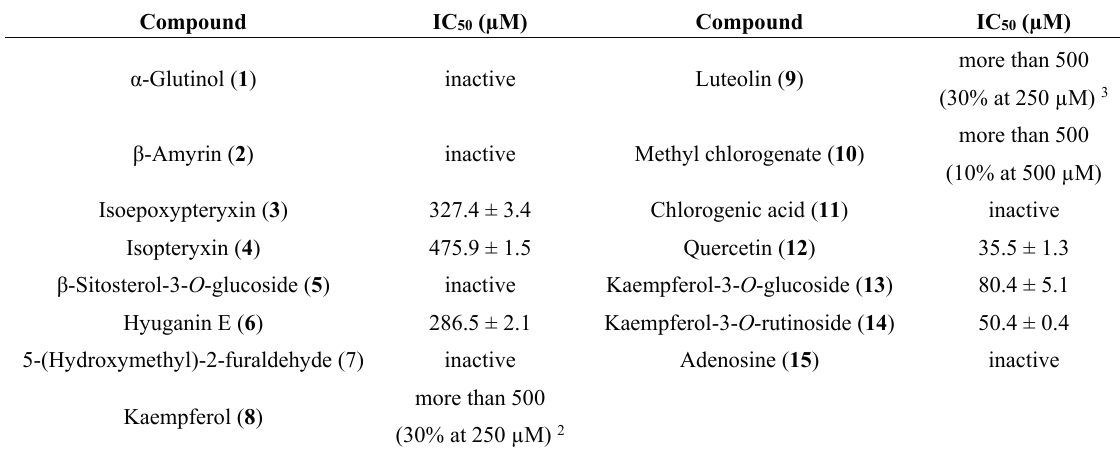
Table 1. IC 50 values of the isolated compounds in the AChEI assay 1